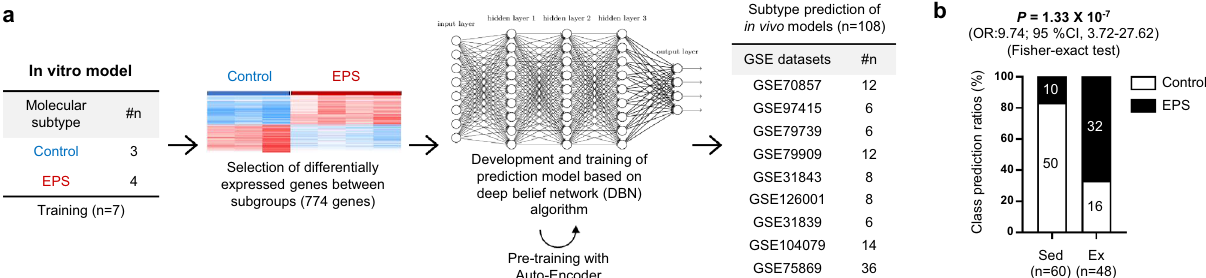
Figure 2. Development of a prediction model using a DBN algorithm. ( a ) Schematic of the molecular subtype in vitro exercise prediction model. Nine publicly available datasets (n = 108) were used to determine the predictive value of the model based on the H2O deep-learning method. ( b ) Prediction results obtained using the molecular subtype prediction model. Among 60 sedentary samples, 50 were predicted accurately as control samples. Among 48 exercise samples, 32 were predicted correctly as EPS samples.